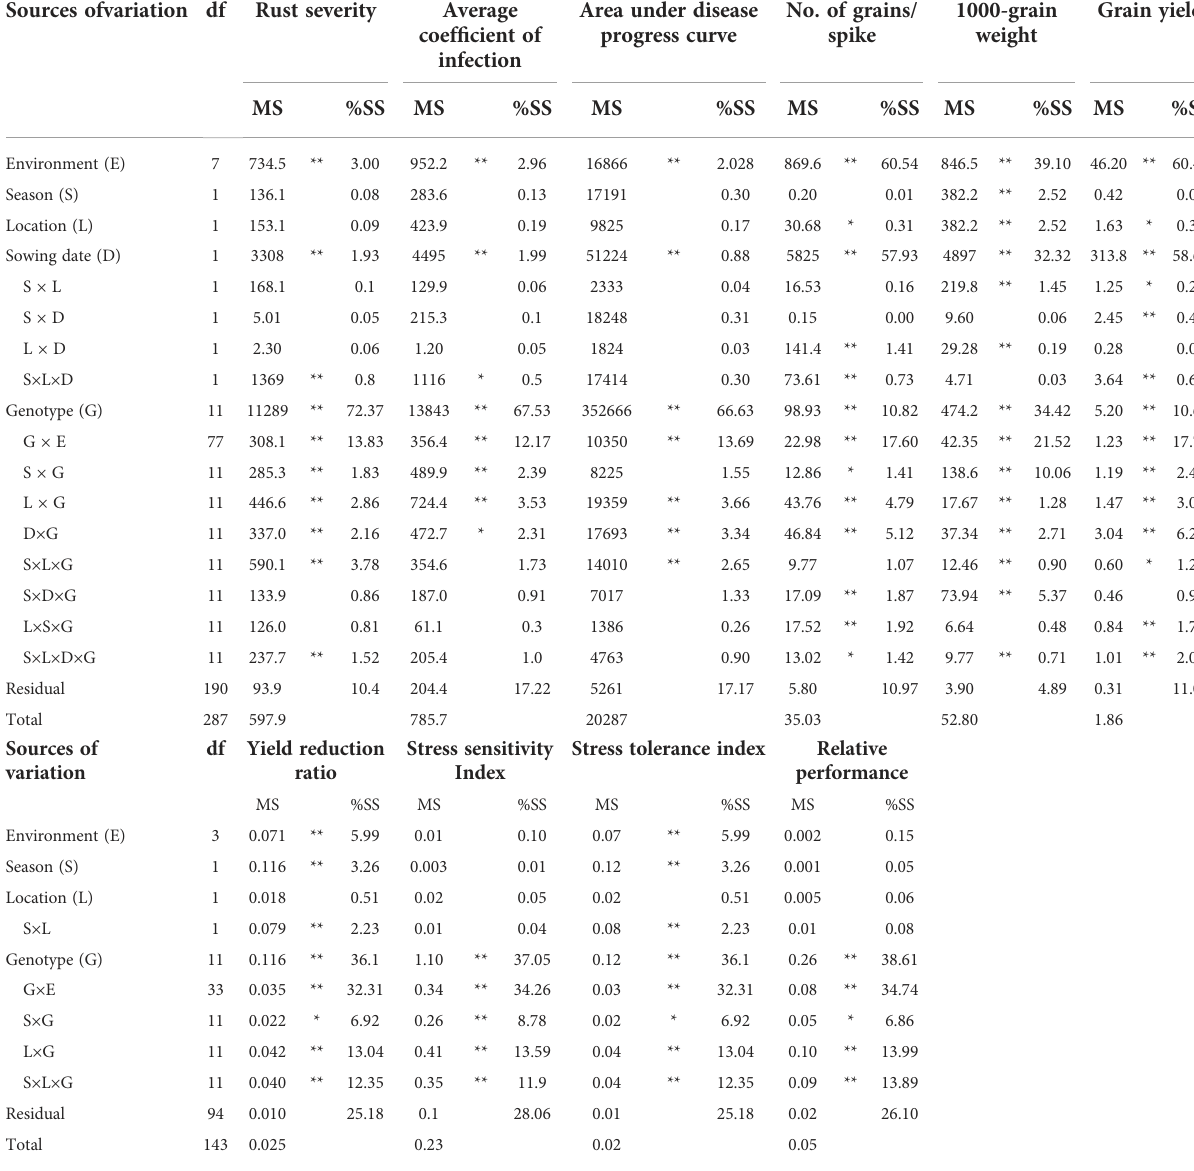
TABLE 2 Analysis of variance for the evaluated parameters of twelve bread wheat genotypes tested in two locations (Kafer El-Hamam and Sakha) during two growing seasons in 2015-2016 and 2016-2017 under timely and late sowing dates. Sources ofvariation